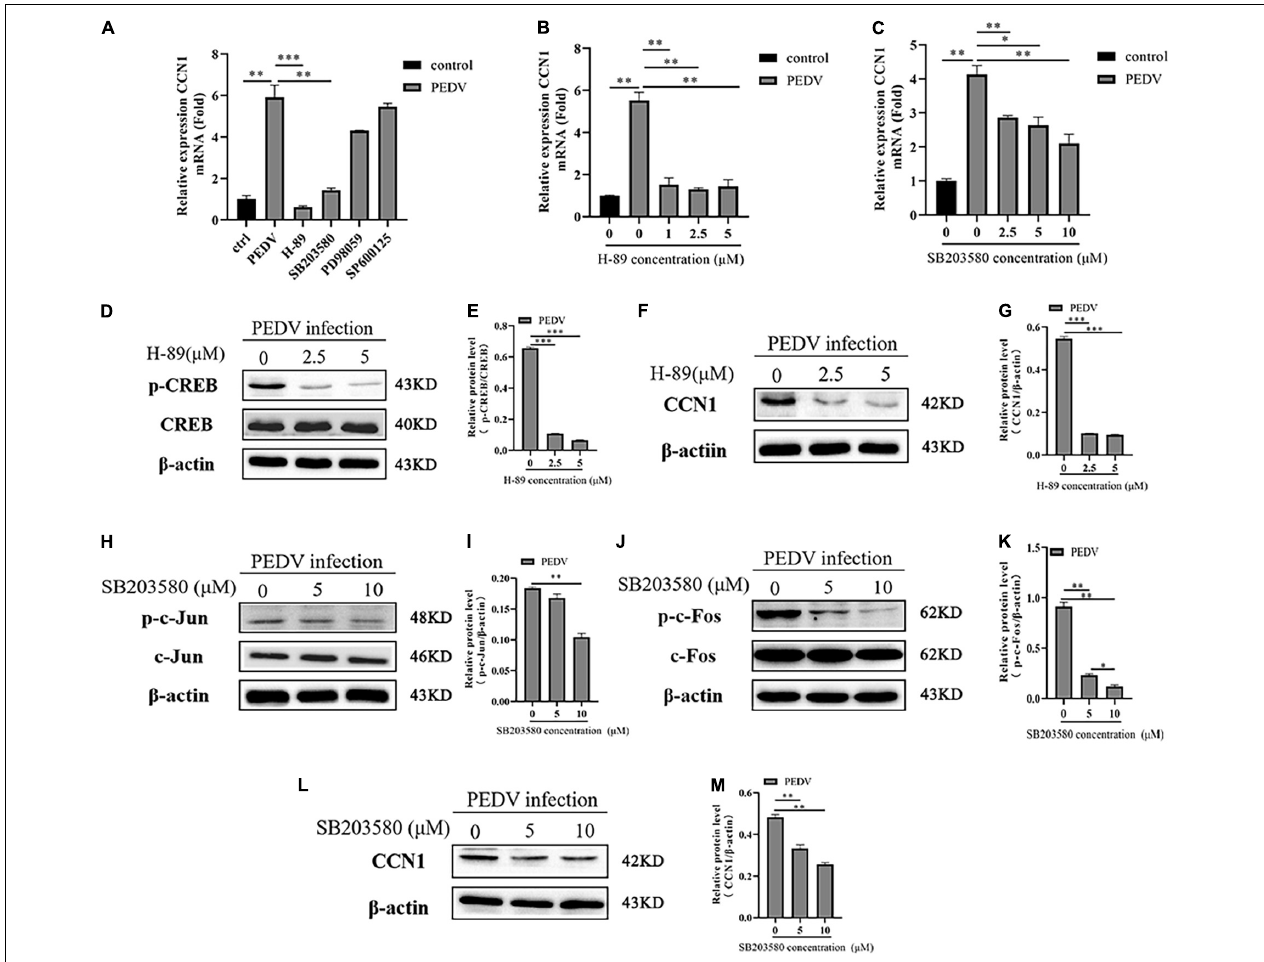
FIGURE 4 | The PKA and P38 pathways are involved in PEDV-mediated the expression of CCN1. (A) Marc-145 cells were pretreated using H-89, SB203580, PD98059, and SP600125 for 1 h then infected with PEDV for 48 h, real-time PCR analyzed the mRNA expression of CCN1. (B) Marc-145 cells were pretreated using H-89 at doses of 1, 2.5, and 5 for 1 h and then infected with PEDV 48 h; real-time PCR analyzed the mRNA expression of CCN1. (C) Marc-145 cells were pretreated using SB203580 at doses of 2.5, 5, and 10 for 1 h and then infected with PEDV for 48 h; real-time PCR analyzed the mRNA expression of CCN1. (D) Marc-145 cells were pretreated using H-89 at doses of 0, 2.5, and 5 for 1 h and then infected with PEDV for 48 h; Western blotting assessed the expression level of CREB and phospho-CREB. (E) Densitometric analysis of phospho-CREB relative to CREB using ImageJ. (F) Marc-145 cells were pretreated using H-89 at doses of 0, 2.5, and 5 µ M for 1 h and then infected with PEDV for 48 h; Western blotting assessed the expression level of CCN1. (G) Densitometric analysis of CCN1 relative to β -actin using ImageJ. (H) Marc-145 cells were pretreated using SB203580 at doses of 0, 5, and 10 µ M for 1 h and then infected with PEDV for 48 h; Western blotting assessed the level of c-Jun and phospho-c-Jun. (I) Densitometric analysis of phospho-c-Jun relative to β -actin using ImageJ. (J) Marc-145 cells were pretreated using SB203580 at doses of 0, 5, and 10 µ M for 1 h and then infected with PEDV for 48 h; Western blotting assessed the level of c-Fos and phospho-c-Fos. (K) Densitometric analysis of phospho-c-Fos relative to β -actin using ImageJ. (L) Marc-145 cells were pretreated using SB203580 at doses of 0, 5, and 10 µ M for 1 h and then infected with PEDV for 48 h; Western blotting assessed the level of CCN1. (M) Densitometric analysis of CCN1 relative to β -actin using ImageJ. The data were performed from three independent experiments. The differences were evaluated using Student’s t -test, and significance differences were denoted by ∗ p < 0.05, ∗∗ p < 0.01, and ∗∗∗ p <